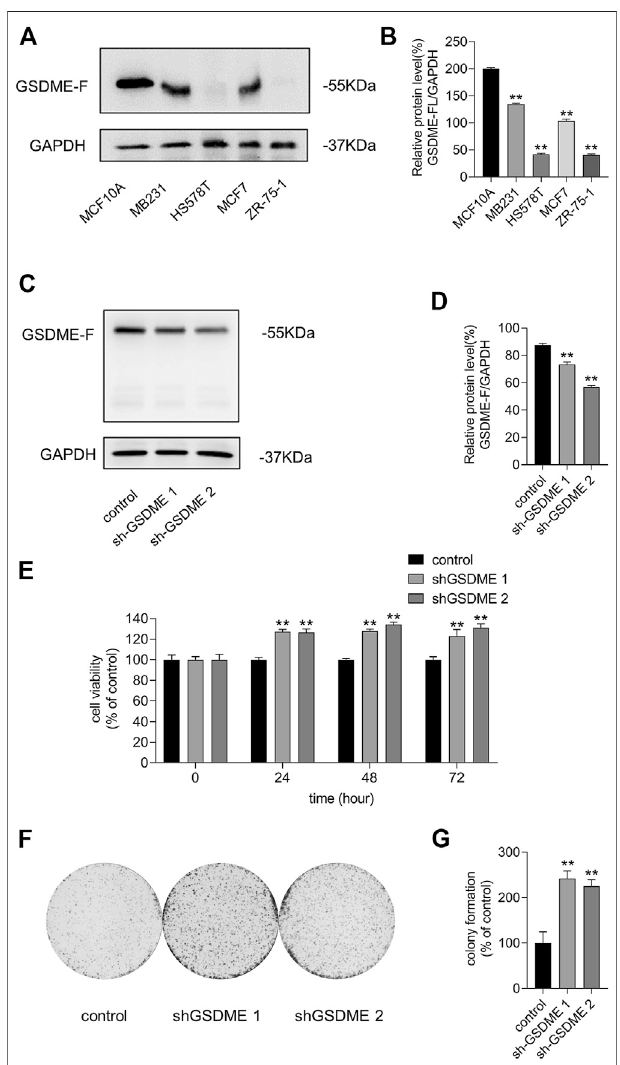
FIGURE 3 | Loss of GSDME expression increased breast cancer cell proliferation and colony ability. (A) The protein level of GSDME was detected bywesternblot. (B) QuantityofGSDMEin (A) . (C) Westernblotwasutilizedto verify the silencing effects of GSDME shRNA plasmids in MCF-7 cells. (D) Quantity of GSDME in (C) . (E) Different time-point cell viability of MCF-7 cells after transfecting GSDME shRNA plasmids and shRNA of control was measured by the CCK8 assay. (F) Colony formation ability measurement of MCF-7 cells after transfecting shRNA of GSDME and shRNA of control. (G) Quantitationofcolonyformationabilityin (F) .Statisticallysigni fi cant:* p < 0.05; ** p < 0.01.